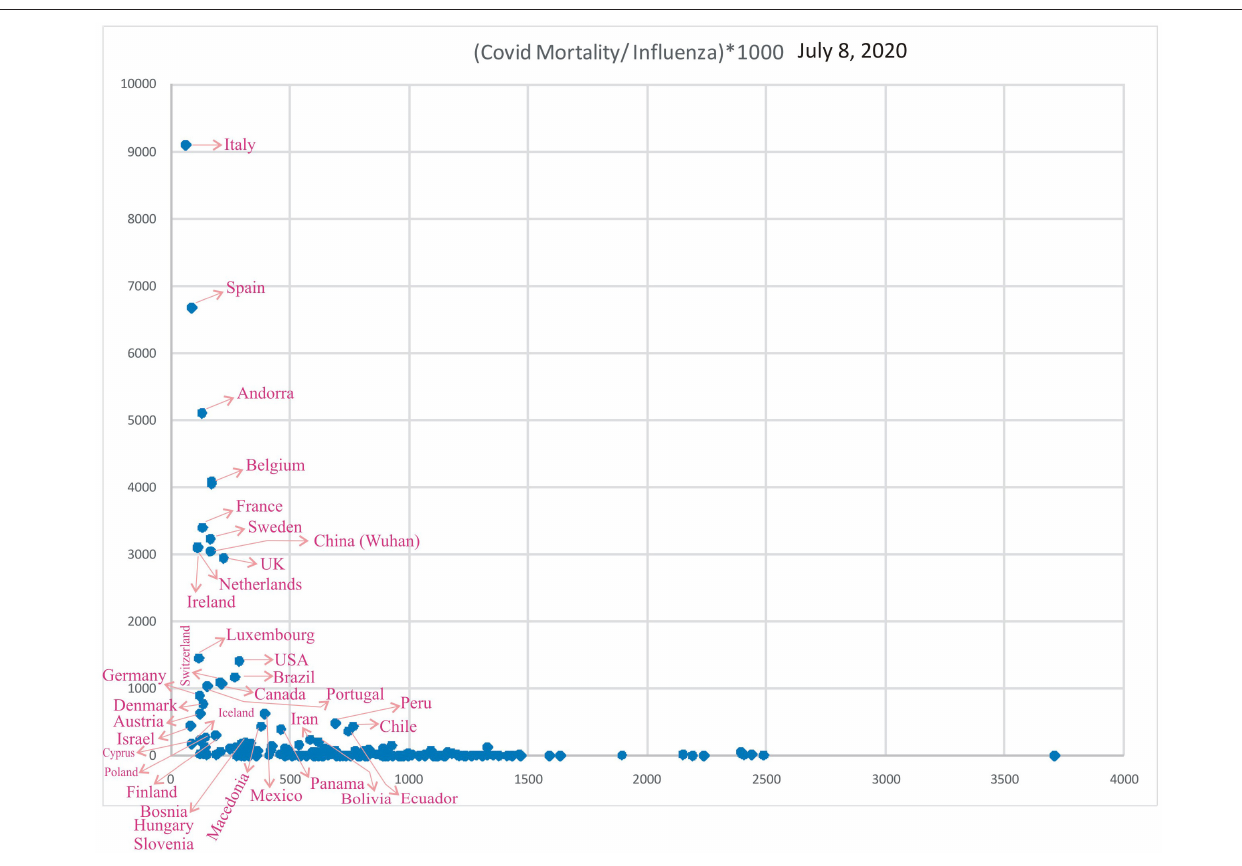
Frontiers in Public Health |